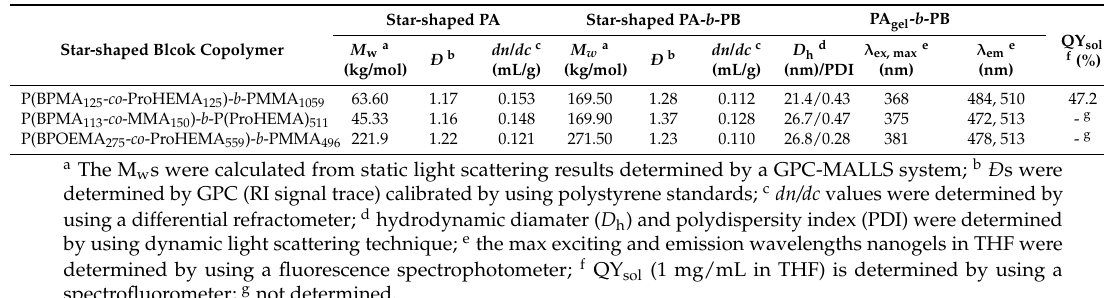
Table 1. Molecular characteristics of star-shaped block copolymers and resulting nanogels.